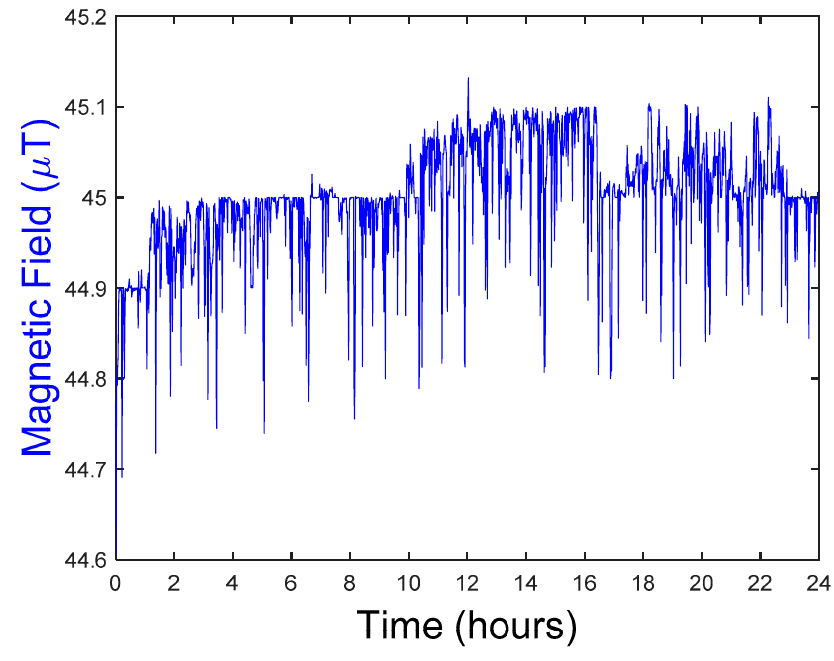
Figure 5 . Example measurements in dwelling n° 47. Time. Figure 5. Example measurements in dwelling n ◦ 47.